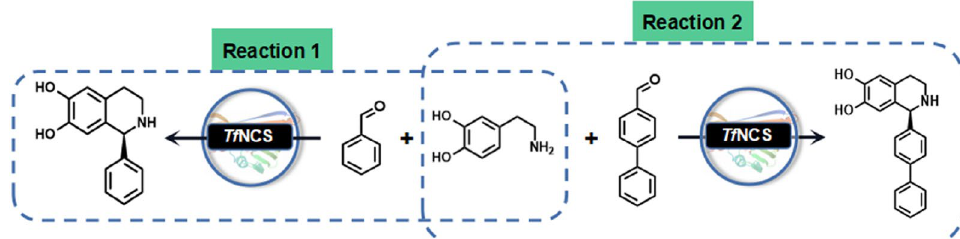
Fig. 2 One‑step synthesis of 1‑aryl‑tetrahydroisoquinolines using norcoclaurine synthase